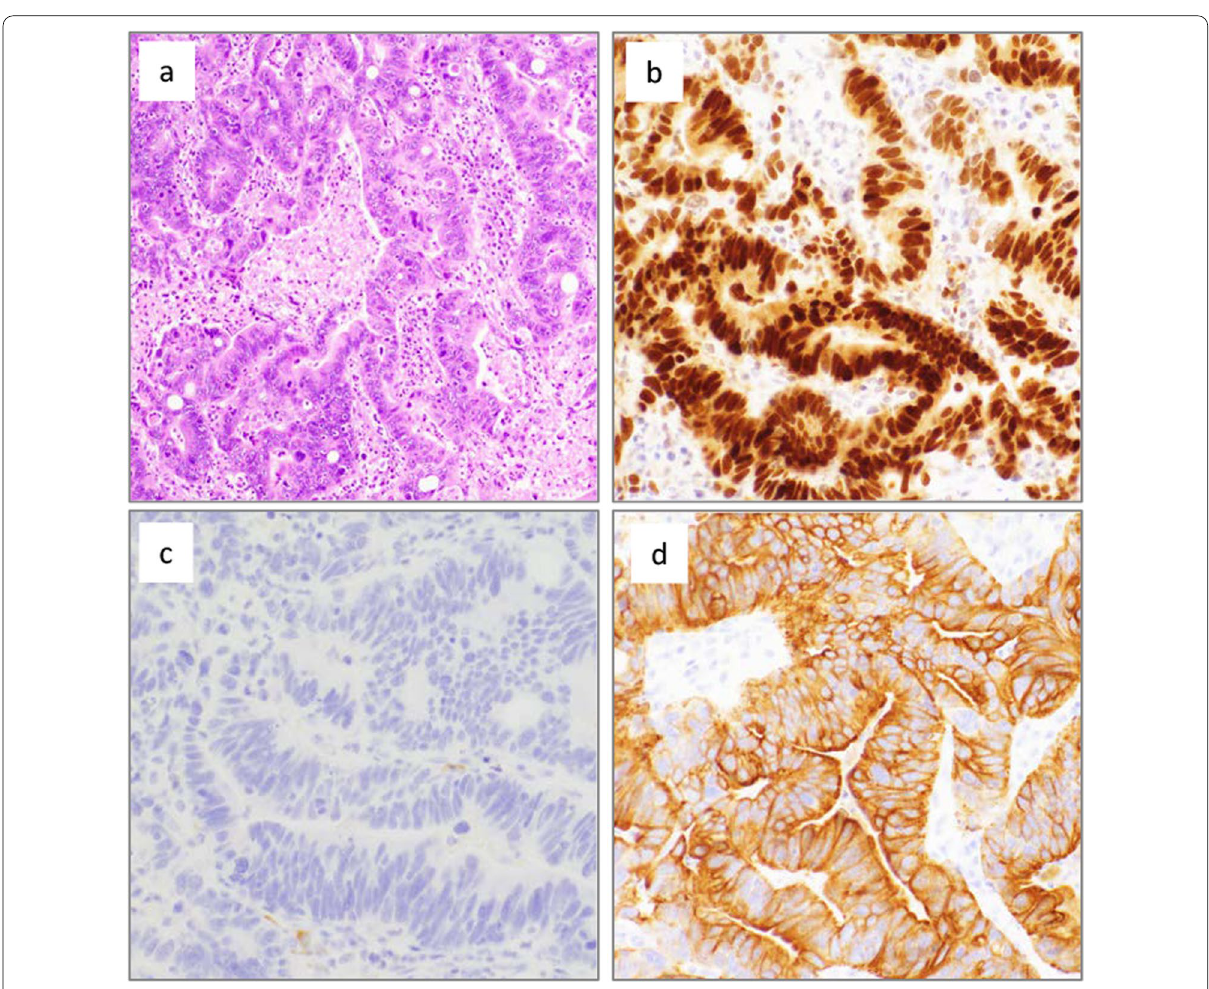
Fig. 2 a Hematoxylin and eosin staining (200 results suggest metastasis from rectal cancer, because immunohistochemical analysis detected CK20 and CDX2 but not